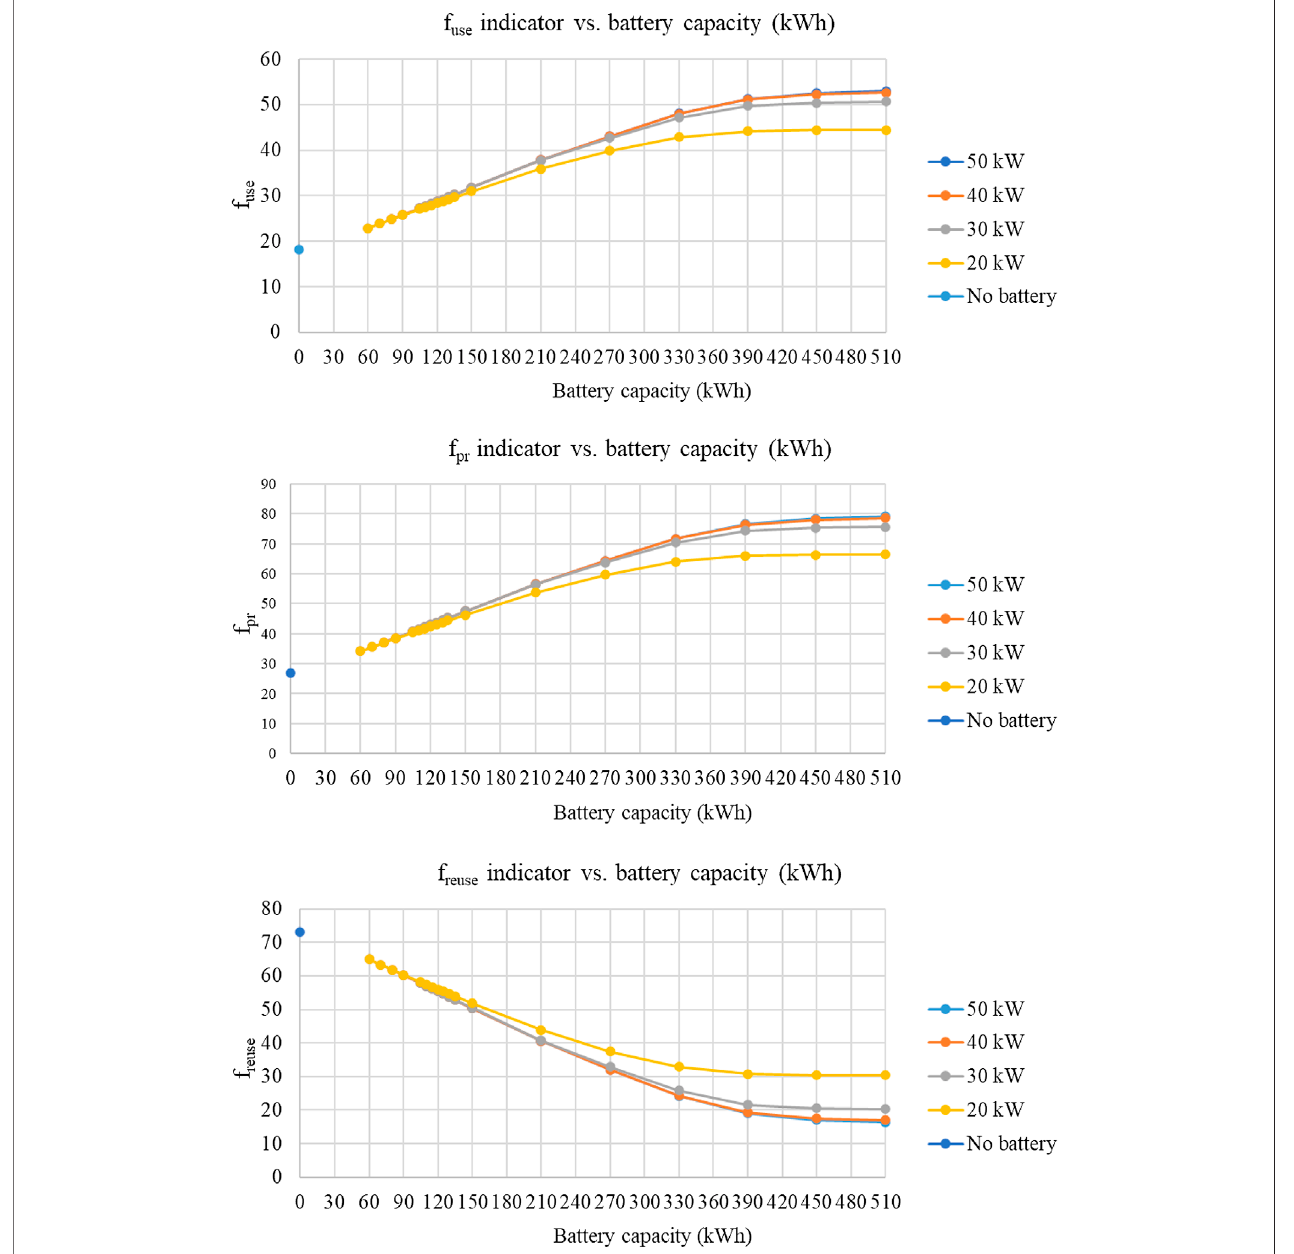
FIGURE 8 | f use , f pr , f reuse vs. battery capacity for different power